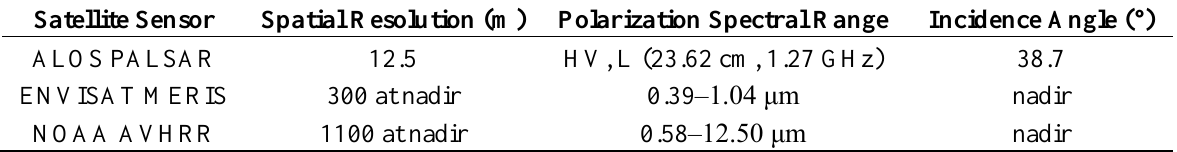
Table 2. Selected details of satellite data applied for the